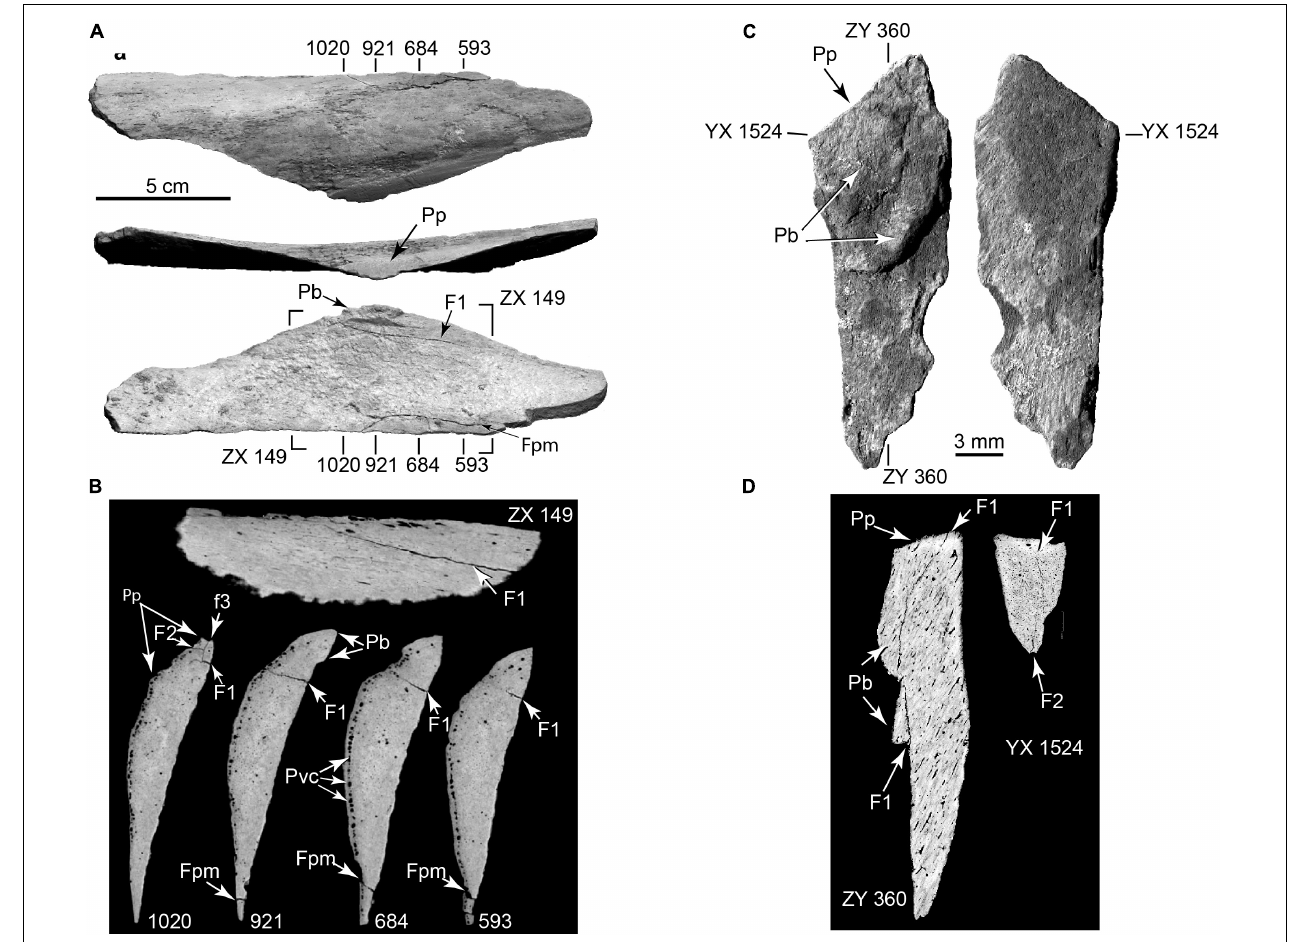
FIGURE 9 | Arrested fractures in bone flake and microflake. (A) Bone flake derived from limb diaphysis in external view (top), percussion surface view (middle), and internal view (bottom). (B) CT slices (numbered) showing arrested fractures (F1, F2, F3) propagating from percussion platform, and postmortem sediment loading fracture (fpm) (TMM 47004-1.70; Supplementary Video 4 ). (C) Opposite surfaces of microflake (TMM 47004-3.5.3a: Supplementary Video 5 ). (D) µ CT slices showing arrested fractures (F1, F2). Pb, bulb of percussion; Pp, percussion platform; Pvc, periosteal vascular